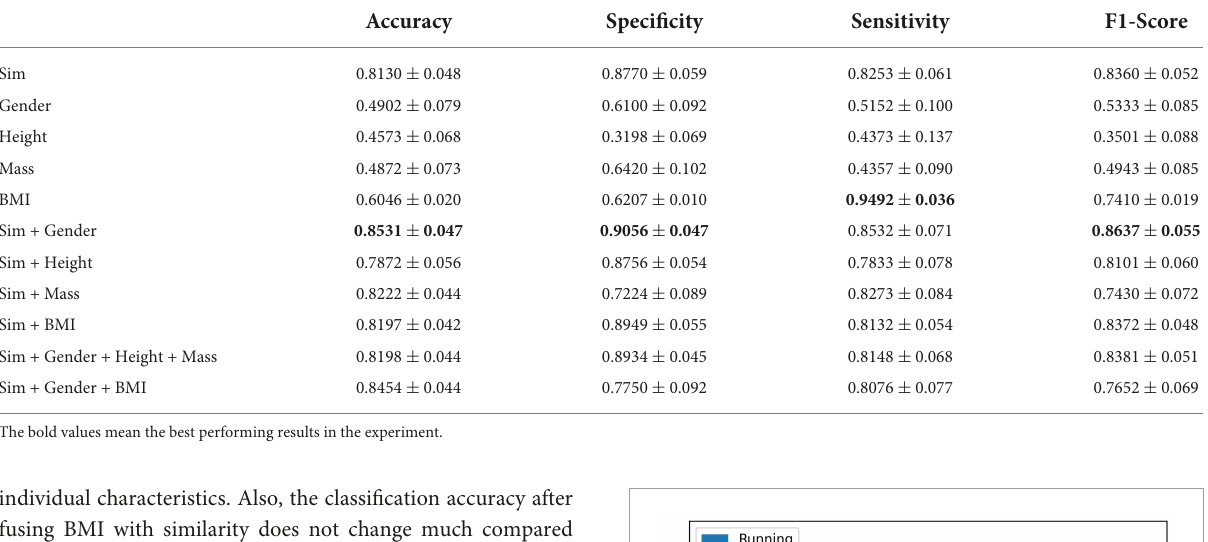
TABLE 2 The effect of feature fusion on classification performance.